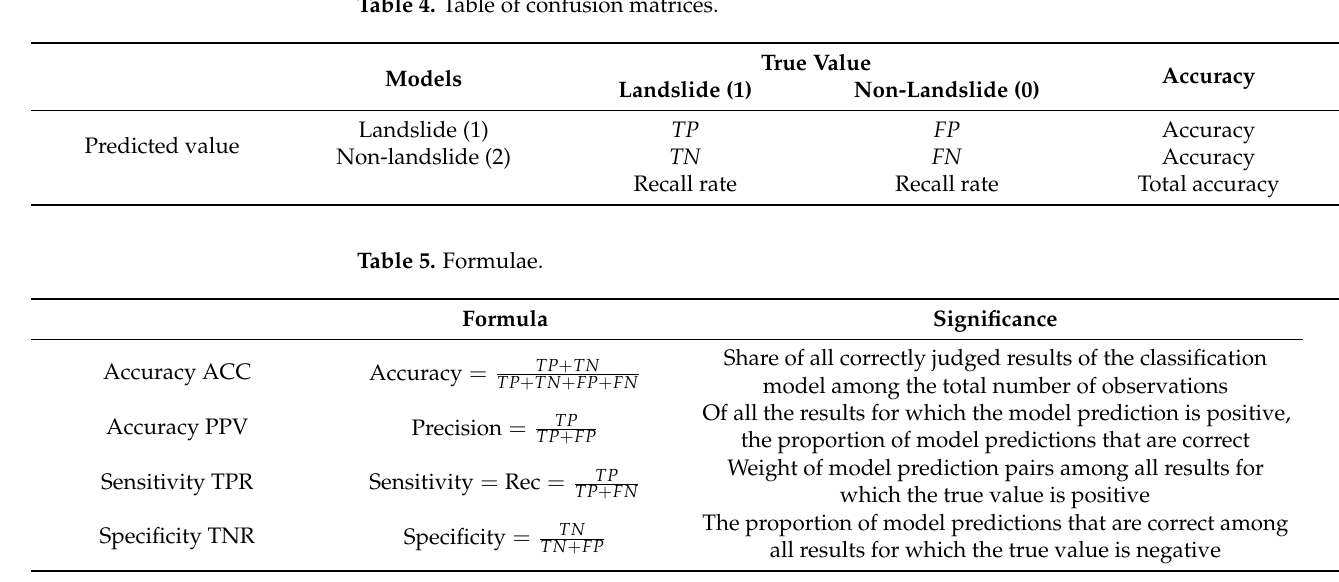
Table 4. Table of confusion matrices.